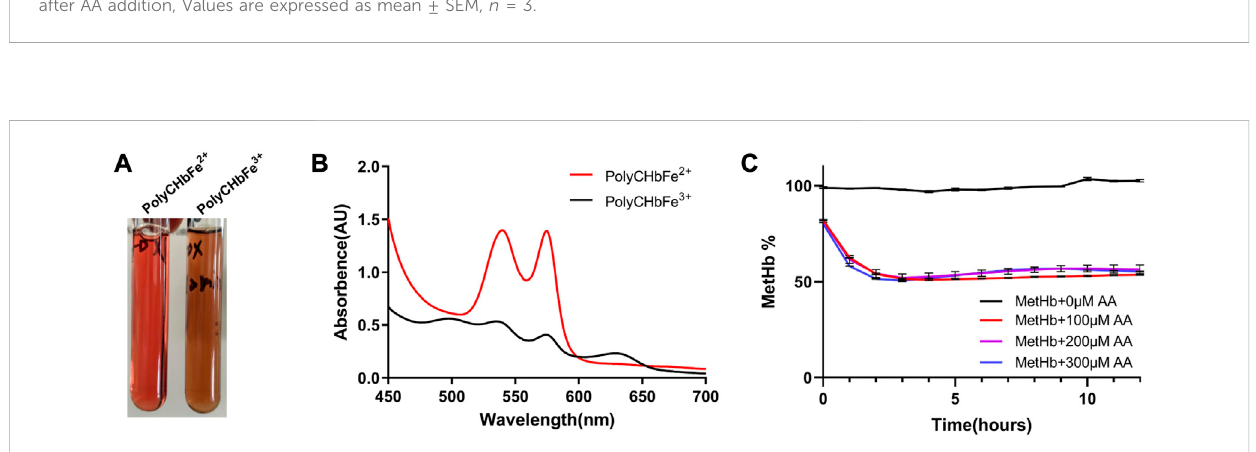
FIGURE 4 A) , the appearance of PolyCHbFe 2+ and PolyCHbFe 3+ , (B) , the full-wavelength scanning diagram of PolyCHbFe 2+ and PolyCHbFe 3+ , (C) , the content of MetHb before and after AA addition. Values are expressed as mean ± SEM, n = 3.